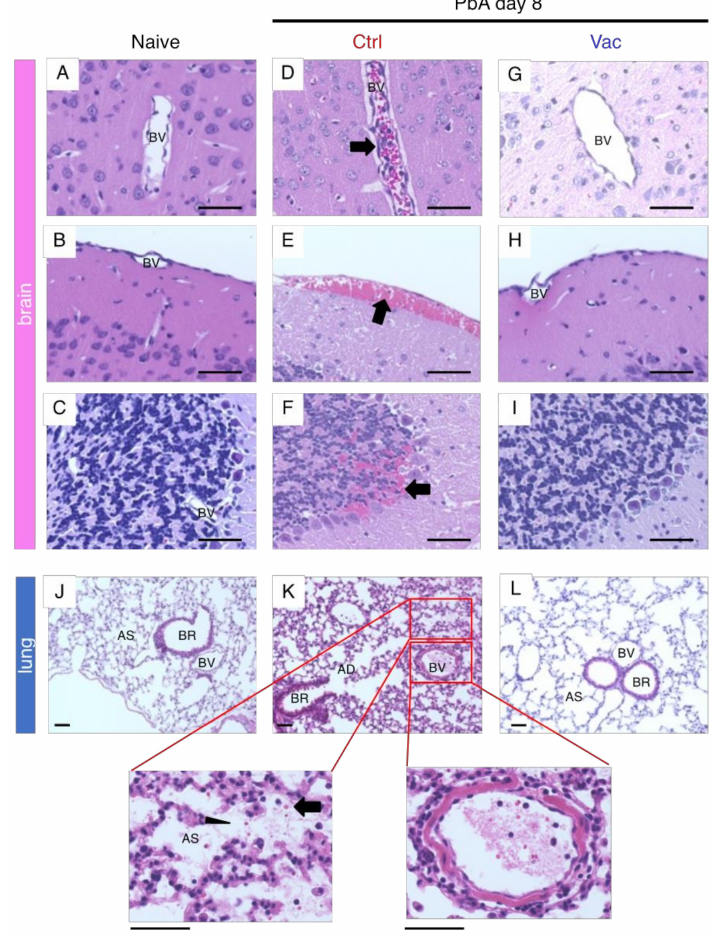
Figure 3. Live vaccination (Vac) with Plasmodium yoelii 17XNL protected the mice from the deadly histopathology caused by P. berghei ANKA (PbA). C57BL/6 mice (naive mice: N = 6, control (Ctrl) mice infected with PbA on day 8: N = 6, Vac mice infected with PbA on day 8: N = 6) were sacrificed. Representative images of sections from brains and lungs stained with hematoxylin and eosin are shown. ( A – C ) Brains of naive mice. ( D – F ) Brains of Ctrl PbA infected mice, which developed experimental cerebral malaria. Arrow indicates RBCs and WBCs sequestrated in ( D ) blood vessel (BV), ( E ) subarachnoid hemorrhage, ( F ) hemorrhage found in the cerebellum. ( G – I ) Brains of Vac mice infected with PbA on day 8. Scale bar: 50 µ m. ( J , K,L ) Mouse lungs. ( J ) Naive mouse lung. ( K ) Ctrl mouse lung infected with PbA, arrow indicates RBC found in the alveolar sac (AS). Arrow indicates pulmonary edema in the AS. ( K ) Sequestration of RBCs and WBCs in the artery. The areas surrounded by red lines are enlarged. ( L ) Vac mouse lung infected with PbA. Scale bar: 50 µ m. BV (blood vessel); BR (bronchi); AD (alveolar